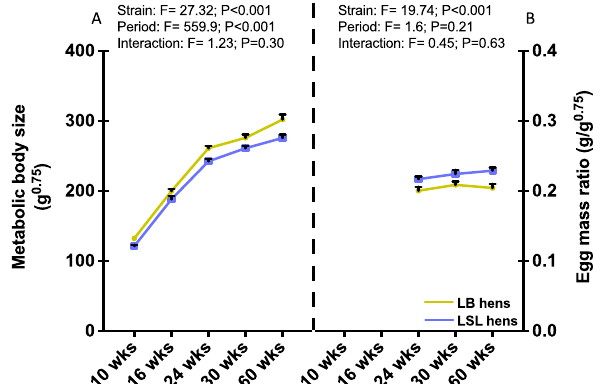
Figure 5. Metabolic body size (left y-axis) ( A ) and egg mass/metabolic size ratio (right y-axis) ( B ) of LB (olive) and LSL (navy) hens at five and three productive periods, respectively. Bars show means ± SEM (n = 10 hens per strain and period). Two-way ANOVA followed by the post-hoc test Tukey HSD (honestly significant difference) were used for statistical analysis. F-values showed the ratio of between-groups to within-groups